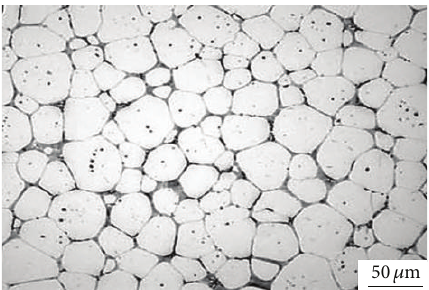
Figure 31: Microstructure of 7075 aluminium alloy obtained by the RAP method [61].